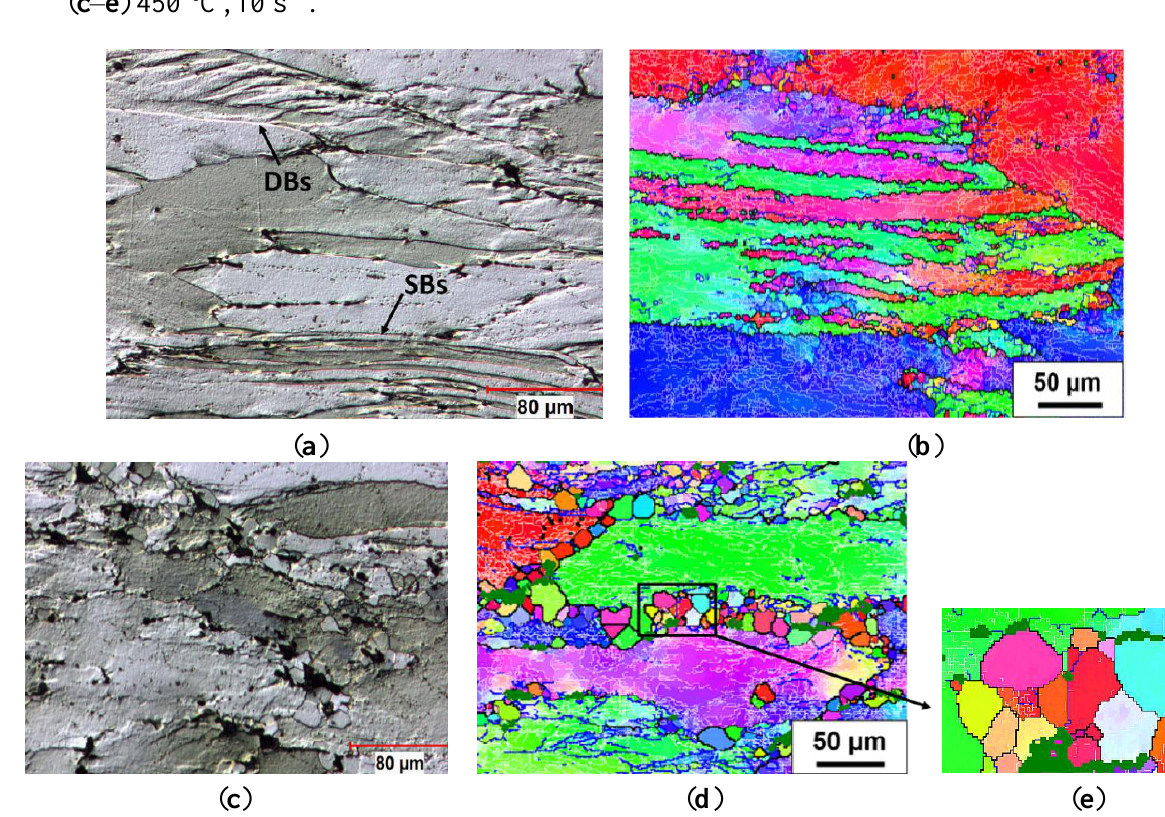
Figure 5. Optical micrographs and orientation imaging maps showing deformed microstructures under different deformation conditions: ( a , b ) 300 °C, 10 s −1 ; and ( c – e ) 450 °C, 10 s −1